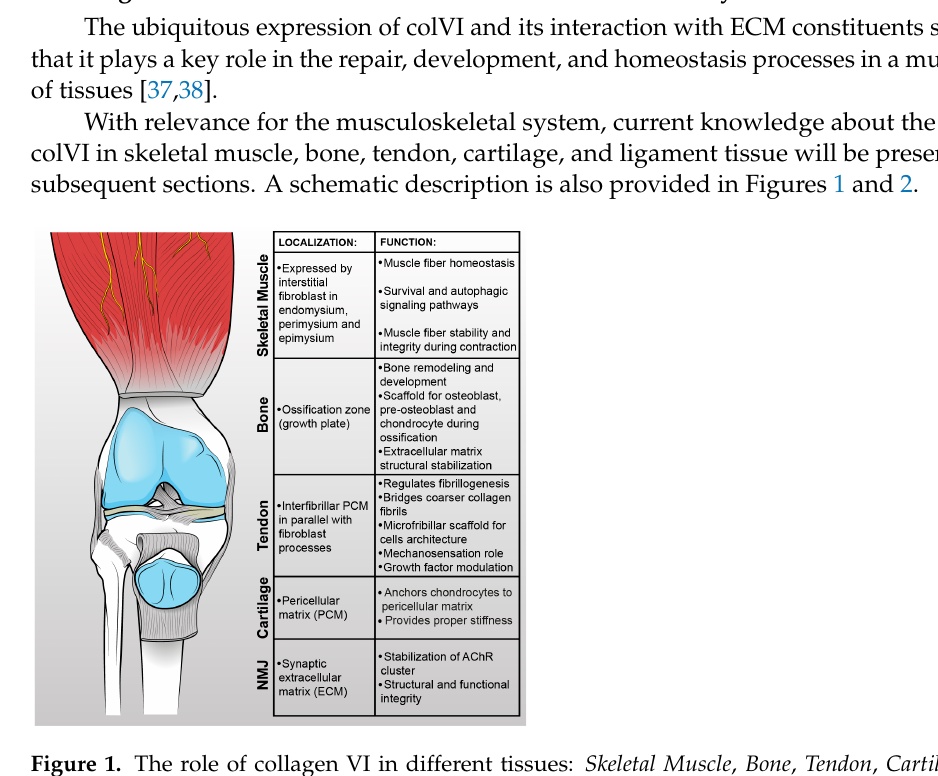
Figure 2. The role of collagen VI in different tissues: Intervertebral disk and Ligament . 4. Skeletal Muscle 4.1. General Aspects Muscle tissue is a highly specialized contractile tissue found in the human body in three types: smooth, cardiac, and skeletal [1].